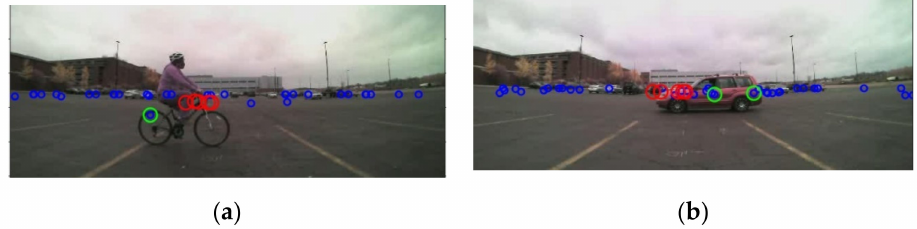
Figure 6. Static and moving points separated and projected: ( a , b ) The small blue dots represent static objects. The green and red circles represent the radar signals for moving objects from left and right radar,